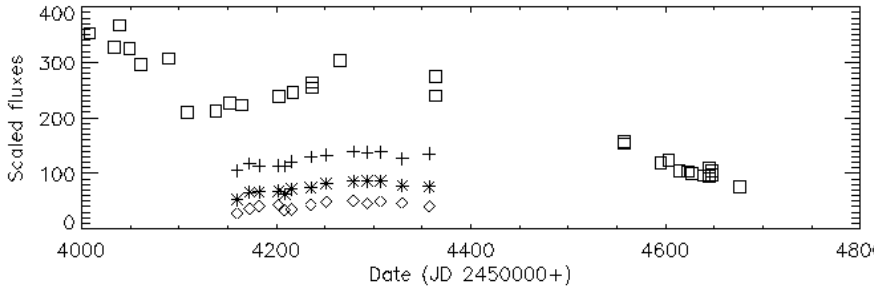
Fig. 1. The Balmer line variations during the 2006–2008 outburst of AG Dra, cor- rected for variations in the continuum flux as described in Shore et al. (2010). Square: H α ; cross, H β ; asterisk: H γ ; diamond, H δ . The outburst covered the orbital interval 5. p 88–7. p 15 with the peak fortuitously occurring near superior conjunction of the